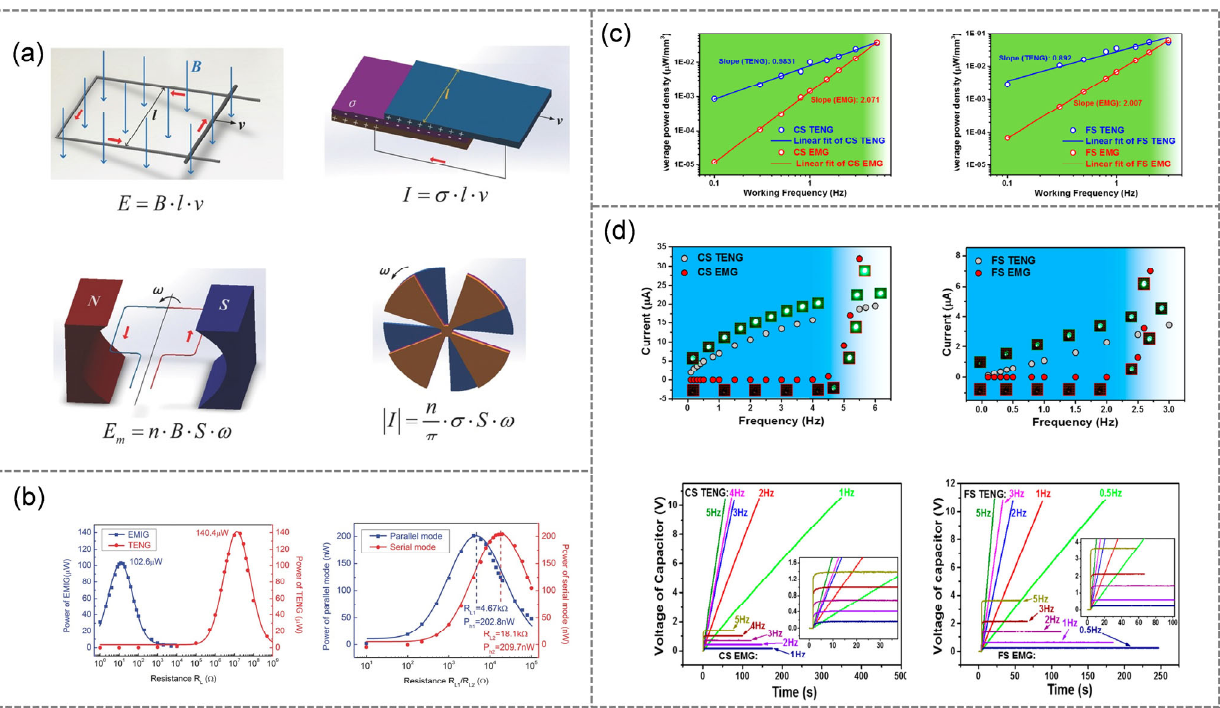
Figure 3. A comparison between EMG and TENG: ( a ) theoretical comparison of EMG and TENG (reproduced with permission [33]. Copyright 2014, Advanced Materials ). ( b ) Output power comparison of the rotating EMG and TENG in different cases (reproduced with permission [33]. Copyright 2014, Advanced Materials ). ( c ) The average power densities of the CS mode and FS mode devices at low frequency (reproduced with permission [34]. Copyright 2016, ACS Nano ). ( d ) The current of the CS mode and FS mode devices passing through LED at low frequency and output performance compared to CS mode and FS mode of EMG and TENG at low frequency (reproduced with permission [34]. Copyright 2016, ACS Nano ).